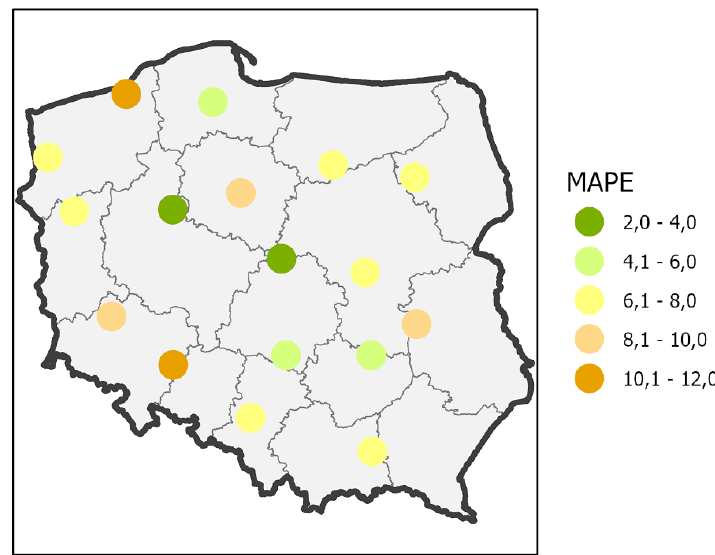
Fig. 8. Spatial differentiation of MAPE values at the test points (source: author’s original